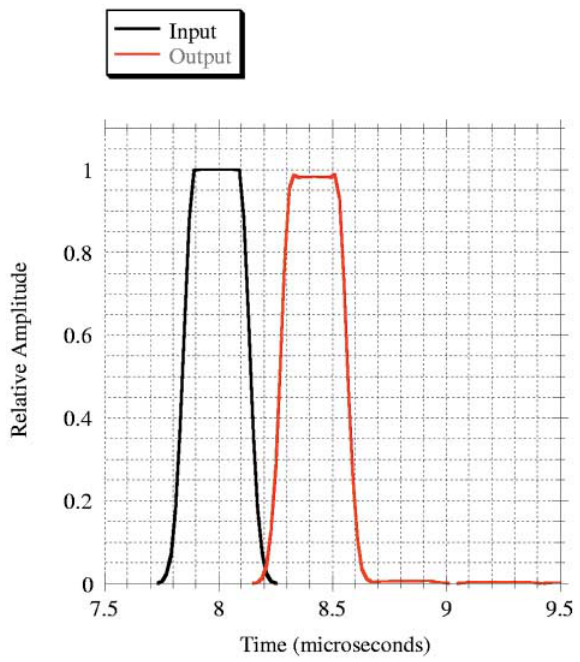
FIG. 28. (Color) Time domain response of the transport line plus the mode launchers (two TE 01 mode transducers plus two arc